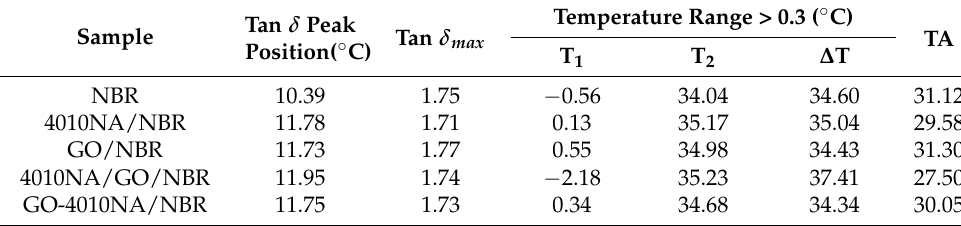
Figure 8. Temperature dependence of ( a ) the loss tangent (tan δ ) values and ( b ) storage modulus for NBR composites. Table 2. Damping properties of the NBR composites.